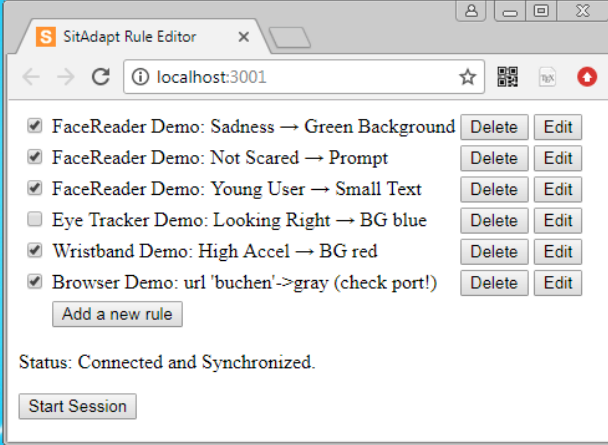
Figure 3. Preselected situation rules that are active at application